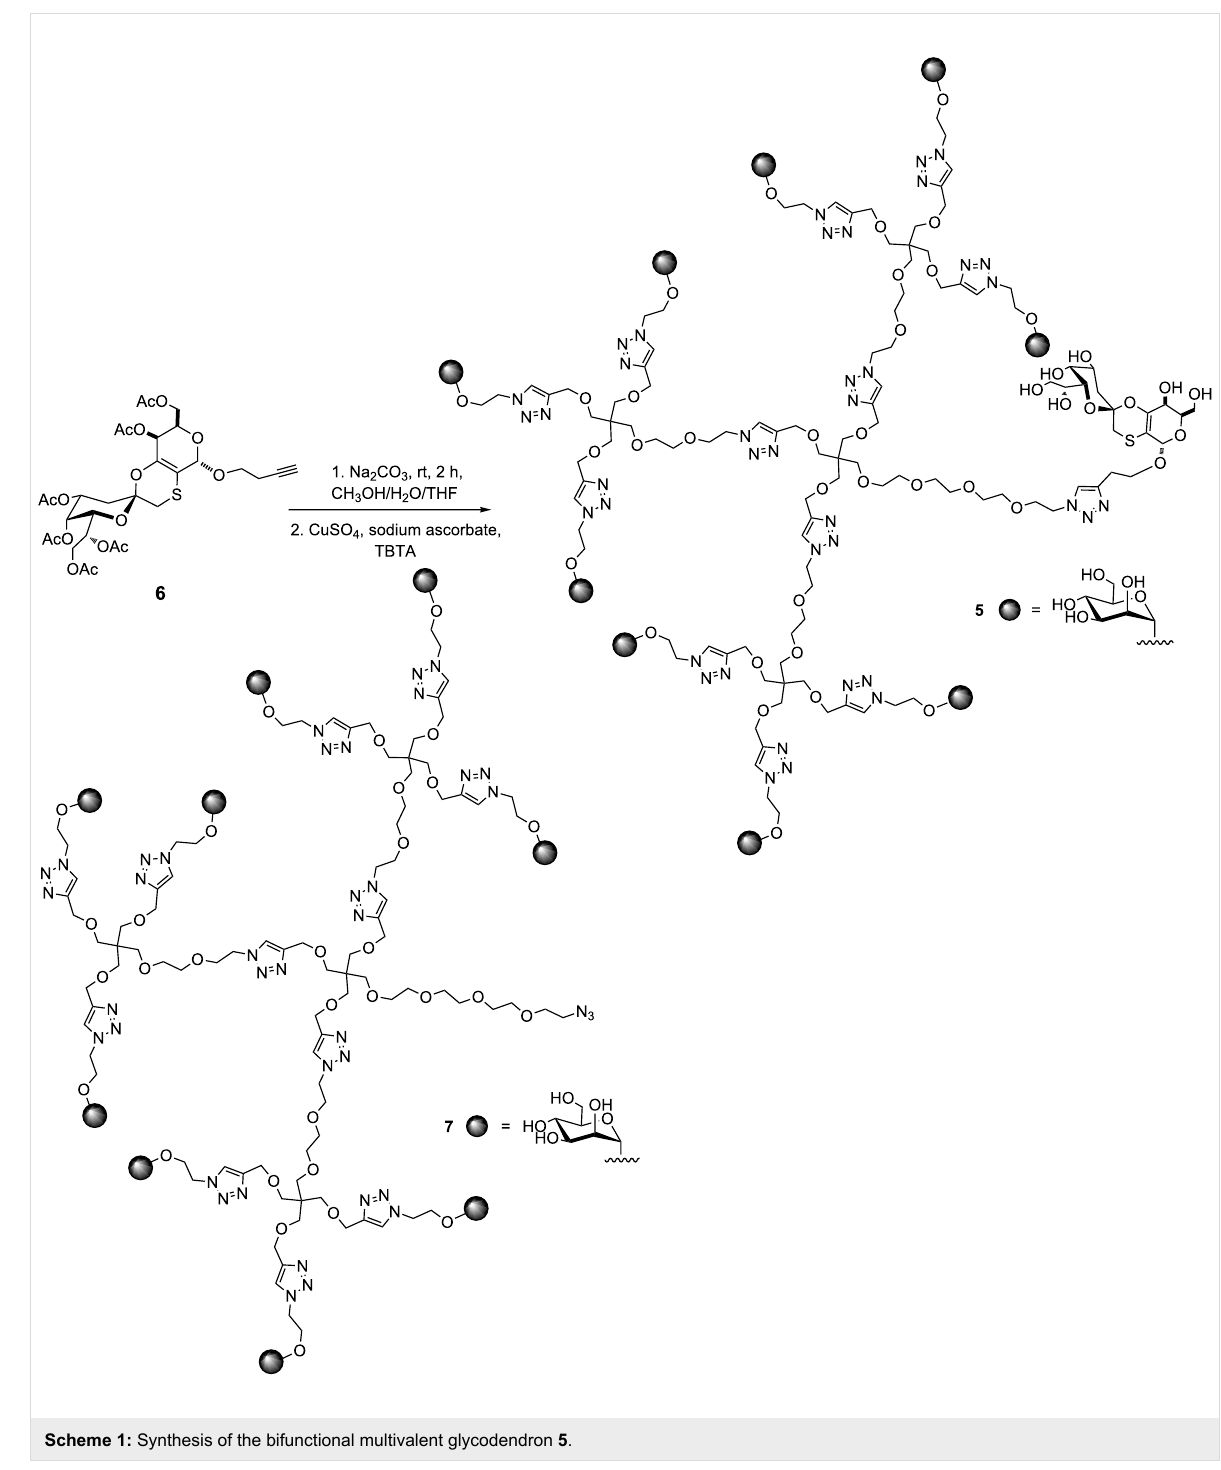
pulsed ex vivo with the corresponding tumor antigen. However, this strategy is complicated and expensive, requiring the isola- tion of patients’ DCs, the pulsing of DCs with the antigen, and their reinsertion. Another approach envisages the targeting